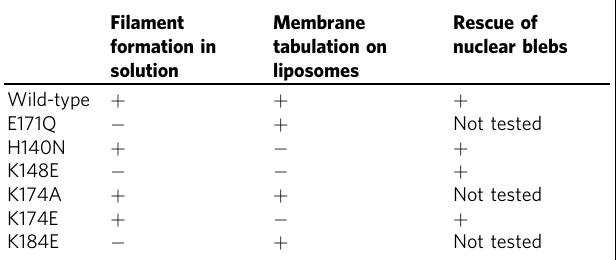
Table 2 Biochemical and functional analysis of